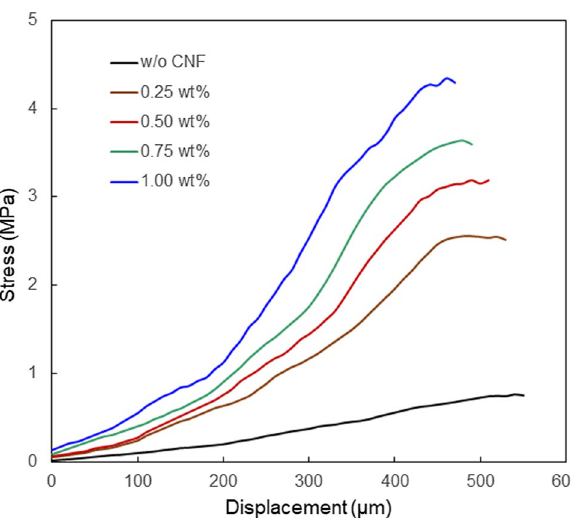
Figure 6. Mechanical properties of the CNF/PEGDA composite hydrogel microstructures at different concentrations of CNF. The concentration of PEGDA was 0.1